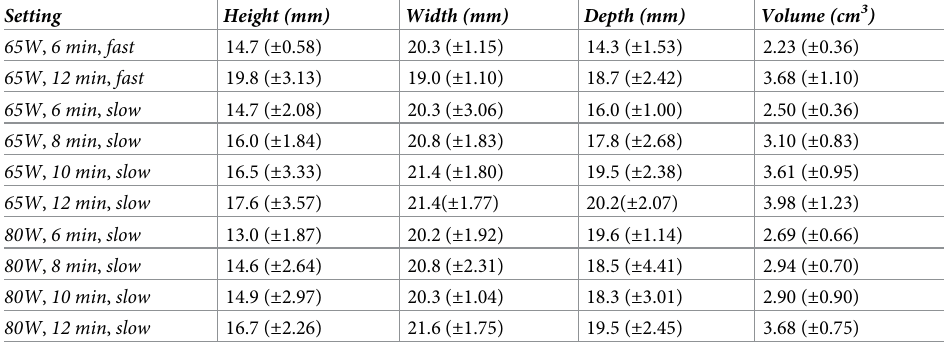
Table 1. Halo volume vs time for different settings for microwave ablation. Blue = 65W slow-cooking, red = 80W slow-cooking, green = 65W fast-cooking.